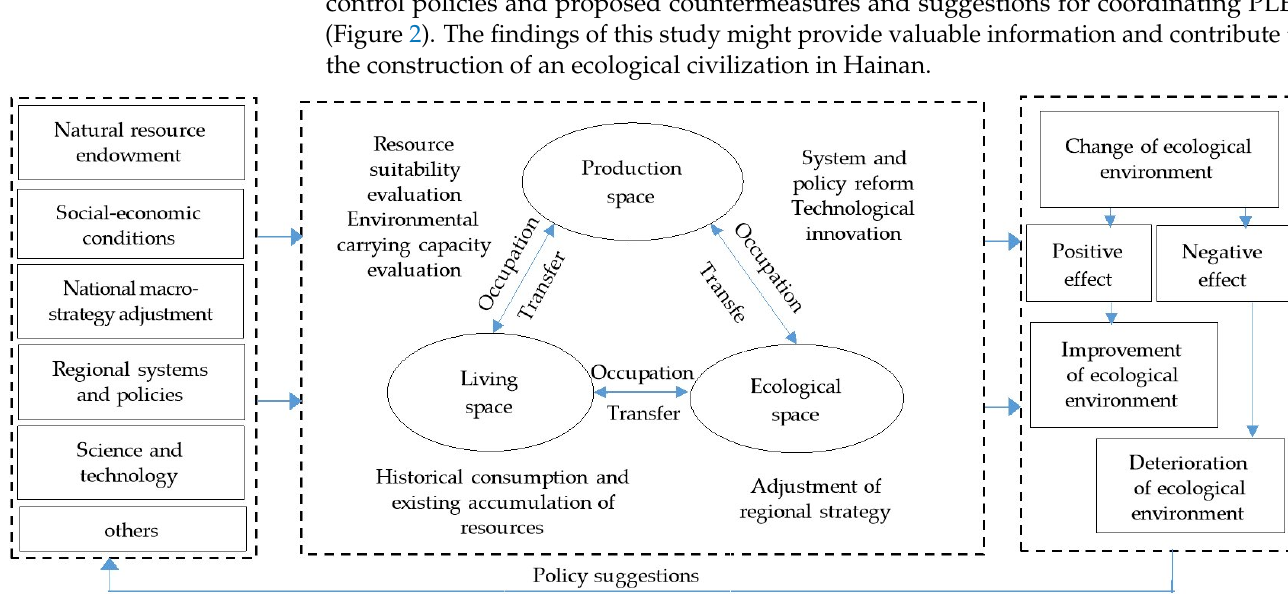
Figure 2. A framework of the analysis [49,50].